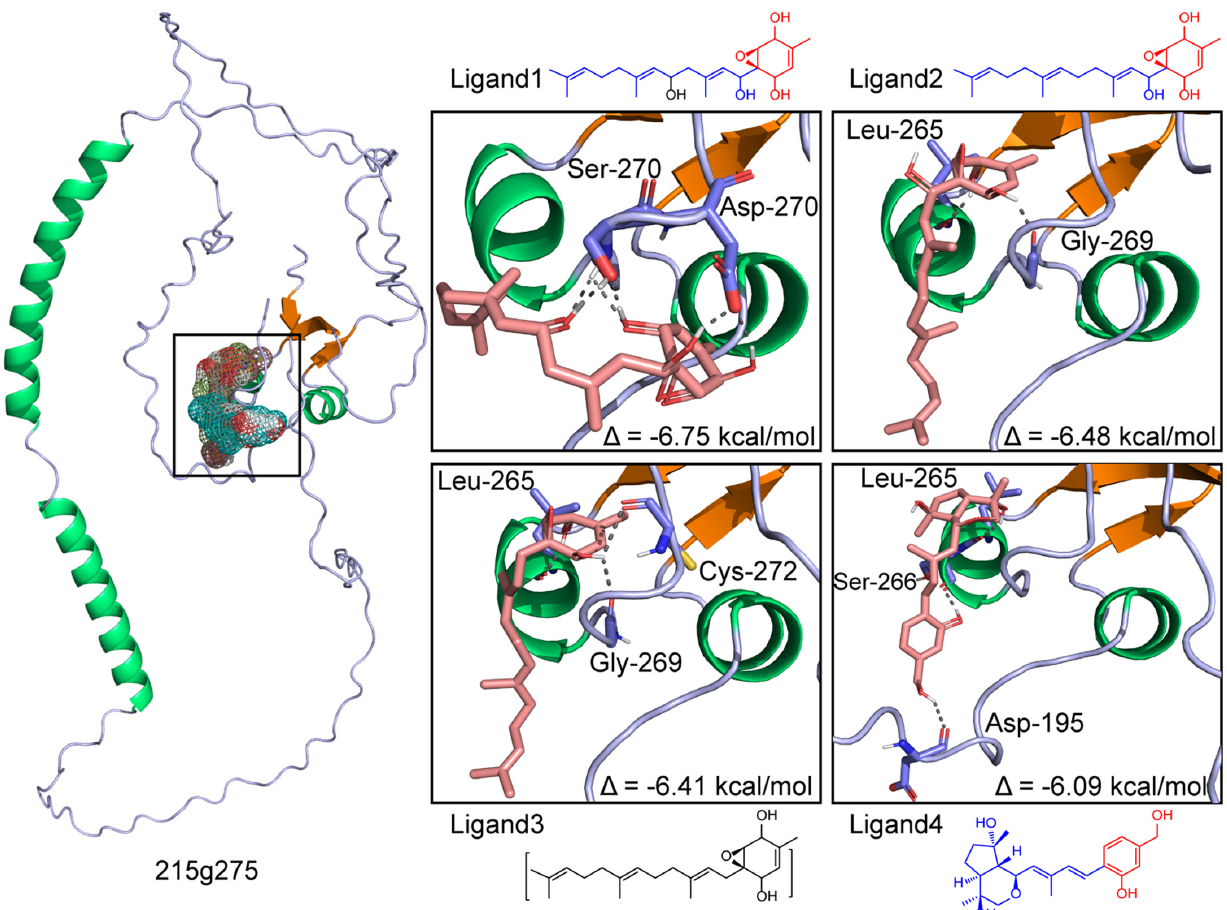
Figure 10. Molecular docking analysis of the strong binding affinity of the SEC metabolites derived from the PKS-PTS hybrid biosynthetic pathway with 275 (binding free energy values below − 6 kcal/mol).